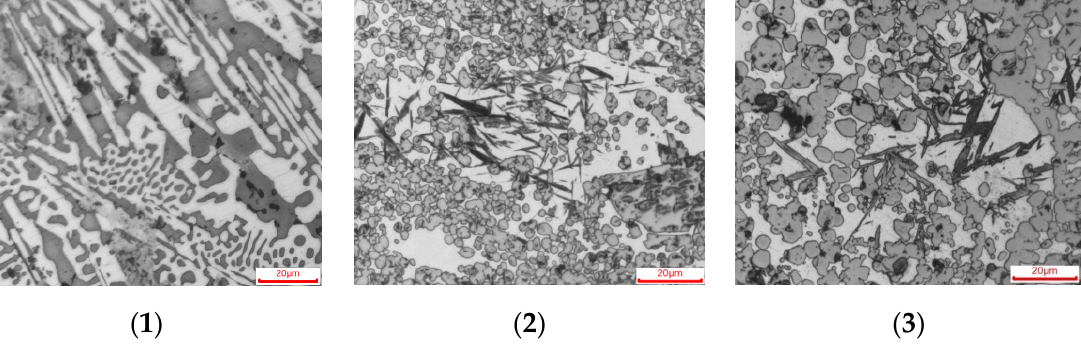
Figure 9. Surface layer microstructure, ( 1 ) High manganese steel, ( 2 ) Medium chromium alloy steel, ( 3 ) High chromium alloy steel.